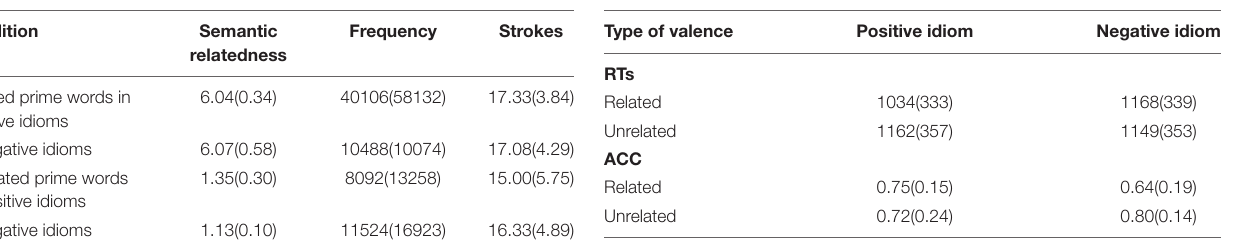
TABLE 7 | Characteristics of prime words in Experiment 2. TABLE 8 | Mean RTs and ACC in Experiment 2 (SDs in parentheses).